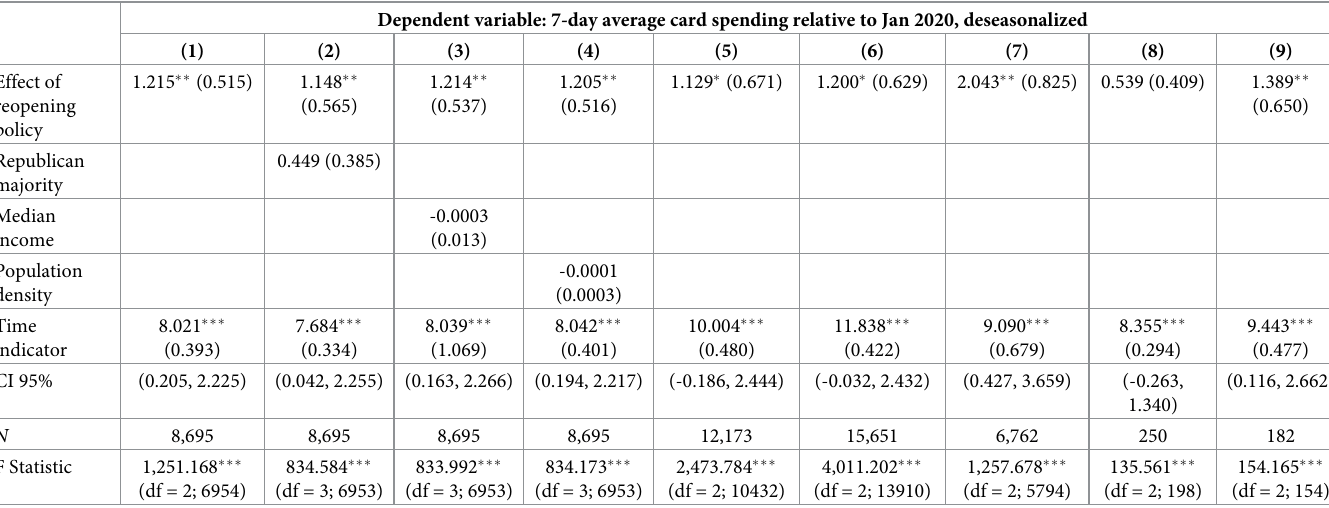
Table 1. Difference-in-differences model results for card